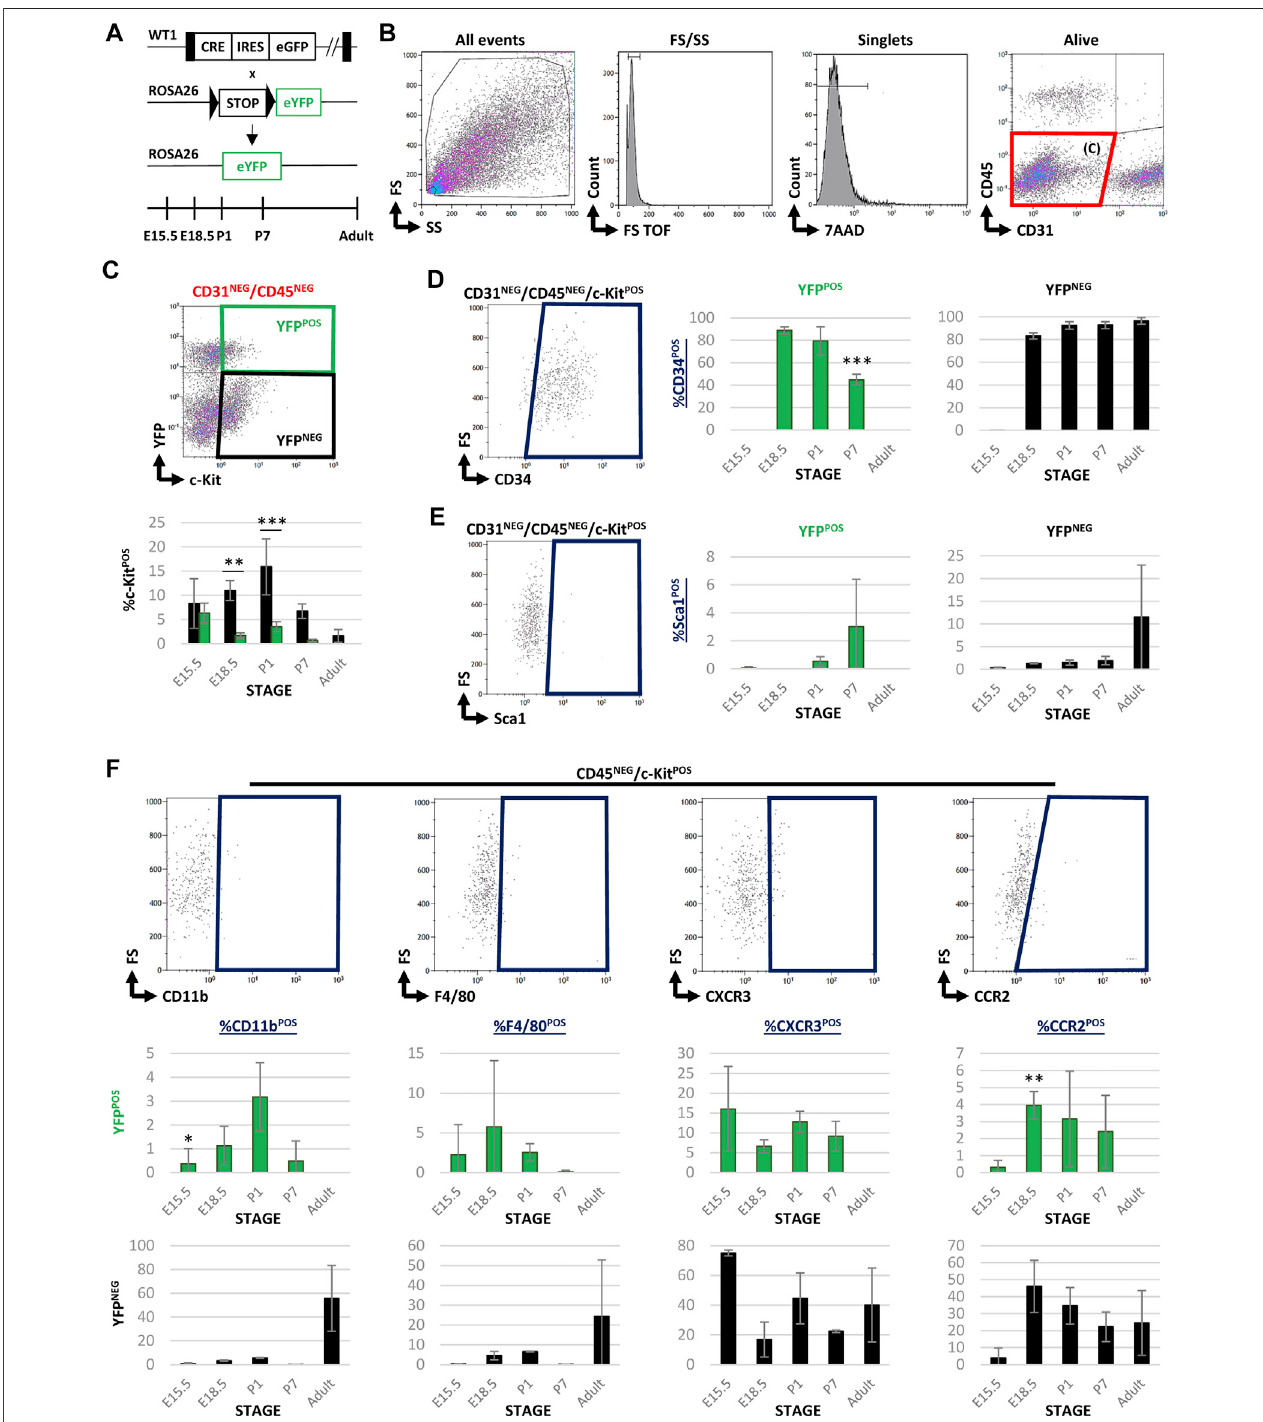
FIGURE 1 | FACS characterization of cardiac c-Kit POS cells during development and adulthood in Wt1Cre-YFP mice. (A) Wt1Cre-YFP mice were generated as shown. The tissue samples were obtained in different time points during embryonic development (E15.5 and E18.5), postnatal stages (P1 and P7), and adult hearts. (B) Representative dot blots and cytograms obtained were obtained from the FACS analysis showing the sequential gating used for the characterization of CD31 NEG / CD45 NEG cardiac interstitial cells. (C) Representative dot blot was used for the characterization of c-Kit and YFP expression within the subpopulation of CD31 NEG / CD45 NEG cells. The same gating was applied for all the different stages included in this study (above). The bar plot representing the percentages of CD31 NEG /CD45 NEG / c-Kit POS cellspresentinallstagesconsidered;YFP NEG (blackbars),YFPPOS(greenbars). (D) RepresentativedotblotforthecharacterizationofCD34 POS cellswithinthe CD31 NEG /CD45 NEG /c-Kit POS subpopulation (left). The bar plots indicated the percentage of CD34 POS cells found in the CD31 NEG /CD45 NEG /c-Kit POS /YFP POS (green